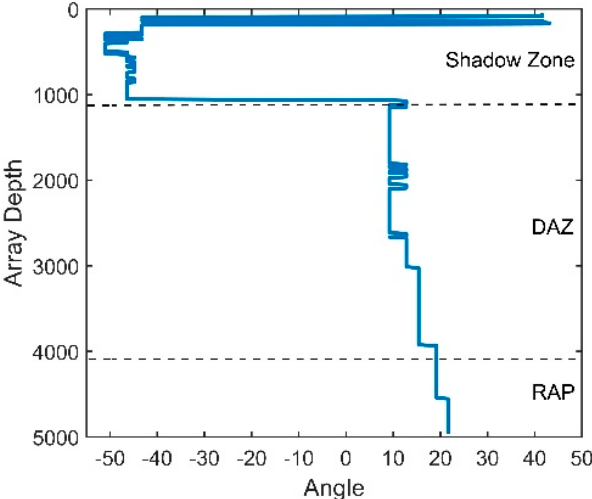
Figure 12. Vertical directionality of signals with different array depths.